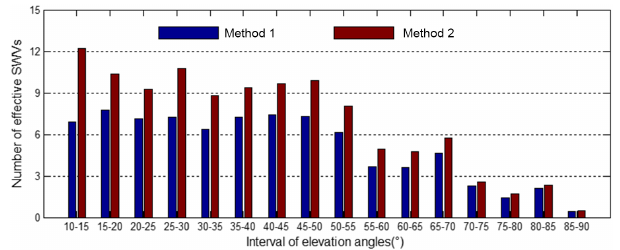
Figure 7. Distribution of effective SWV signals with elevation an- gle for different